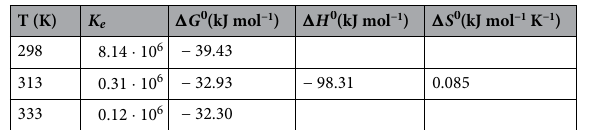
Table 2. Thermodynamics parameters for Hg(II) adsorption on rGO at different temperatures.